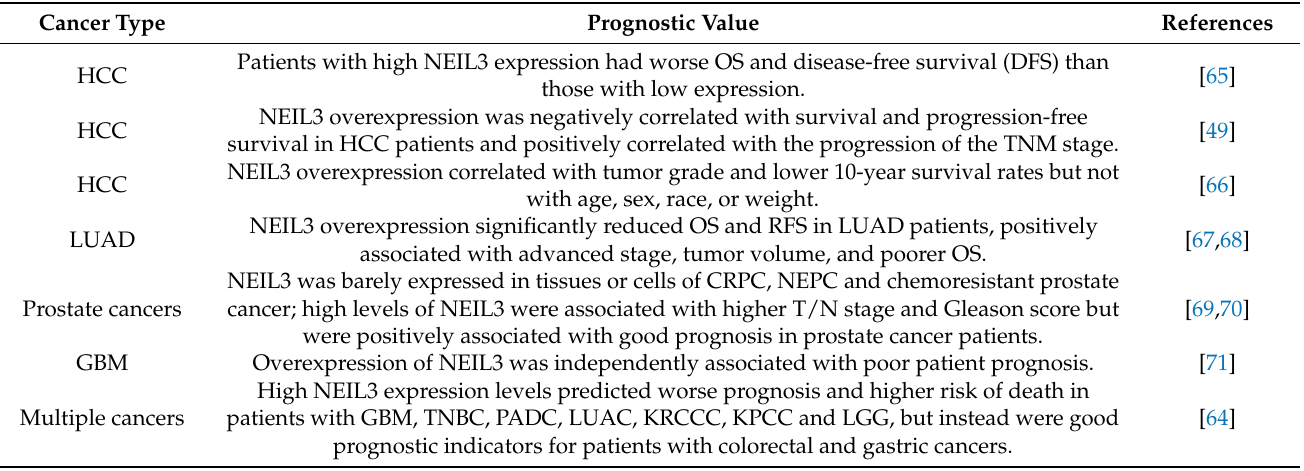
Table 1. Prognostic value of NEIL3 in related